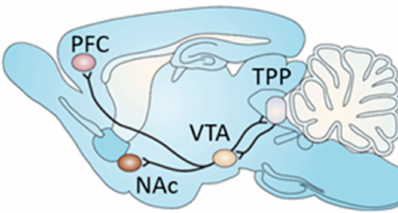
Figure 1. A diagram of a rat brain showing the mesocorticolimbic dopamine pathways. (Adopted from [15]).